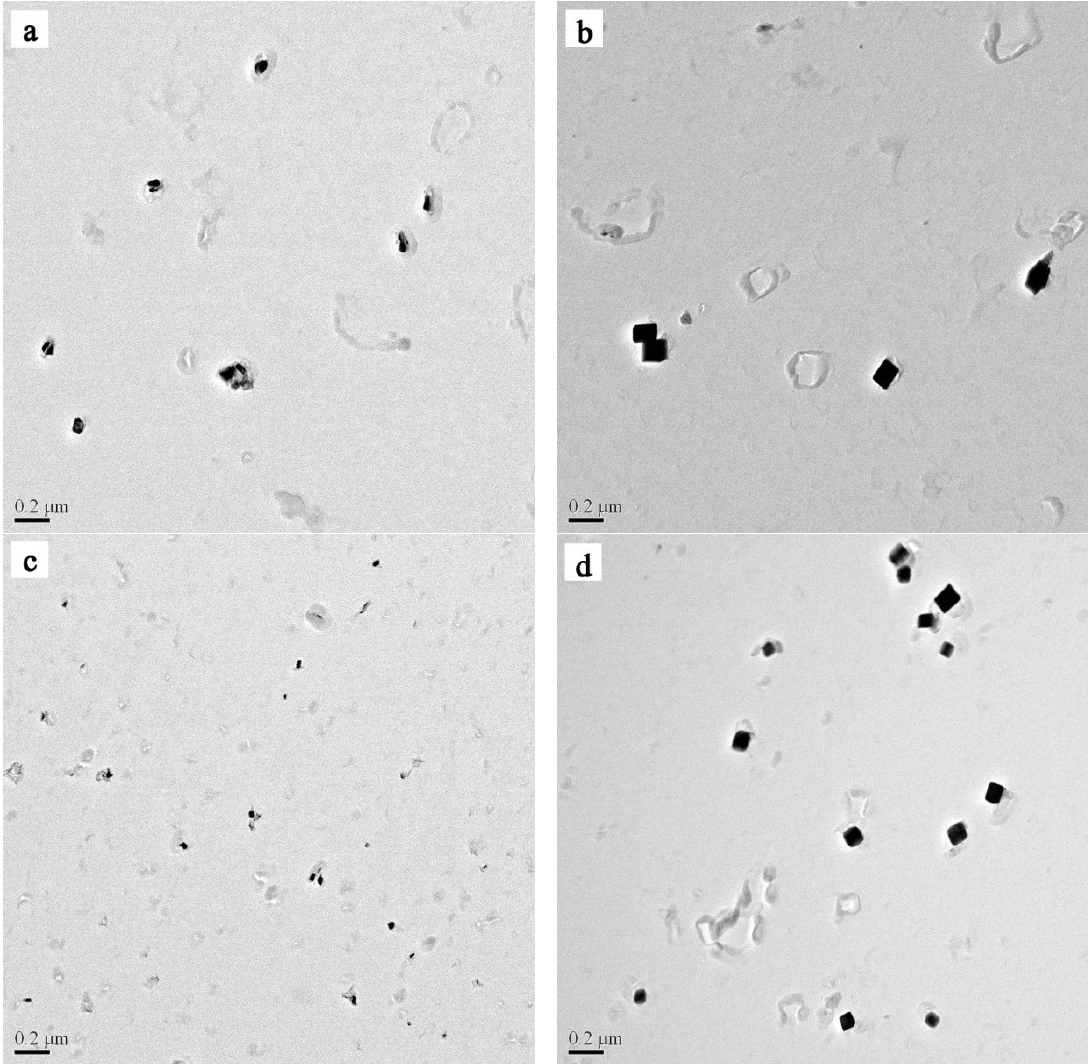
Figure 2: TEM images of precipitates in (a) S1-hot rolled, (b) S2-hot rolled, (c) S1-normalized, and (d) S2-normalized